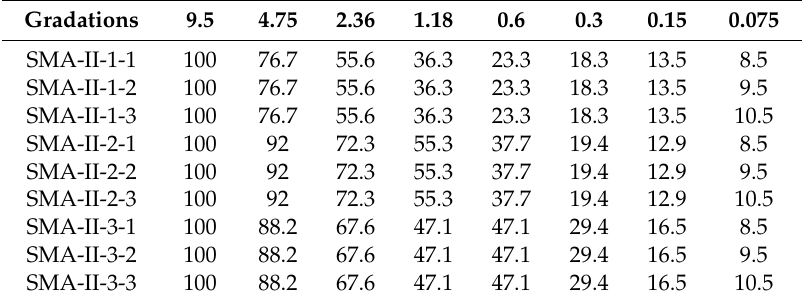
Table 10. Gradation with different passing rate of 1.18-mm and 0.075-mm sieves.